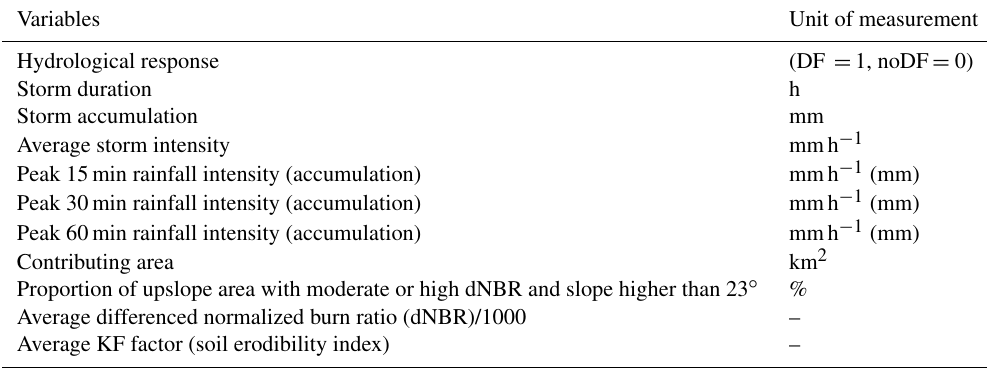
Table 1. A summary of variables reported in the post-fire debris flow database. Variables Unit of measurement Hydrological response (DF = 1, noDF = 0) Storm duration h Storm accumulation mm Average storm intensity mmh − 1 Peak 15min rainfall intensity (accumulation) mmh − 1 (mm) Peak 30min rainfall intensity (accumulation) mmh − 1 (mm) Peak 60min rainfall intensity (accumulation) mmh − 1 (mm) Contributing area km 2 Proportion of upslope area with moderate or high dNBR and slope higher than 23 ◦ % Average differenced normalized burn ratio (dNBR)/1000 – Average KF factor (soil erodibility index)